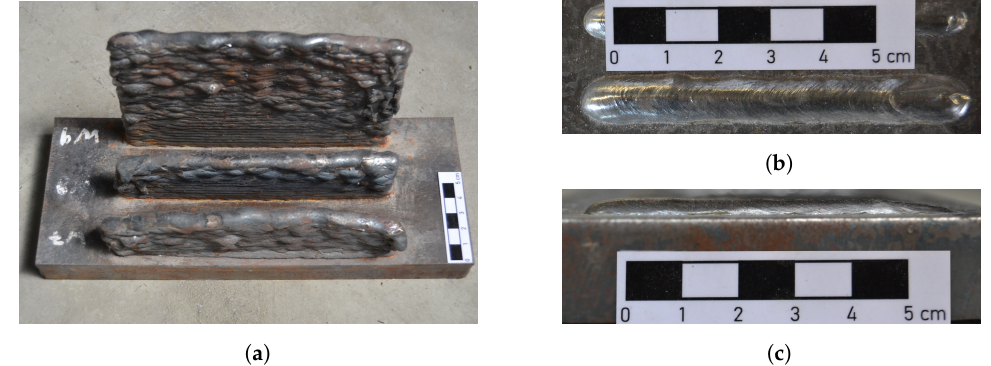
Figure 3. ( a ) First trials on building up straight walls; Single Layer ( b ) Top view and ( c ) Side view.